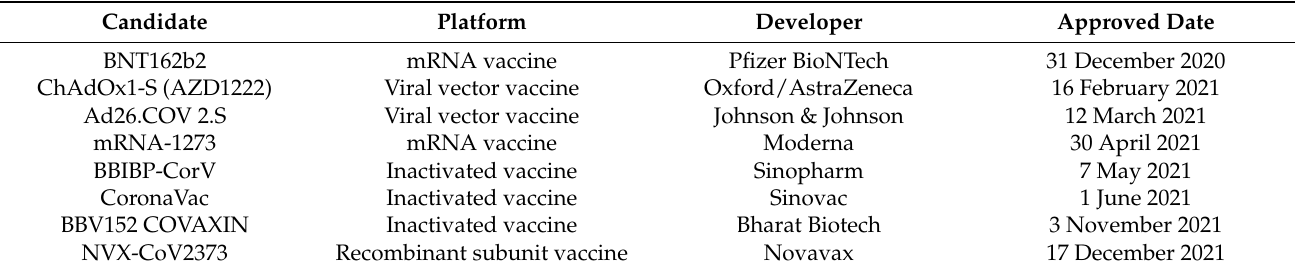
Figure 1. Different platforms used for development of vaccines. Table 1. Landscape of vaccine candidates for COVID-19.